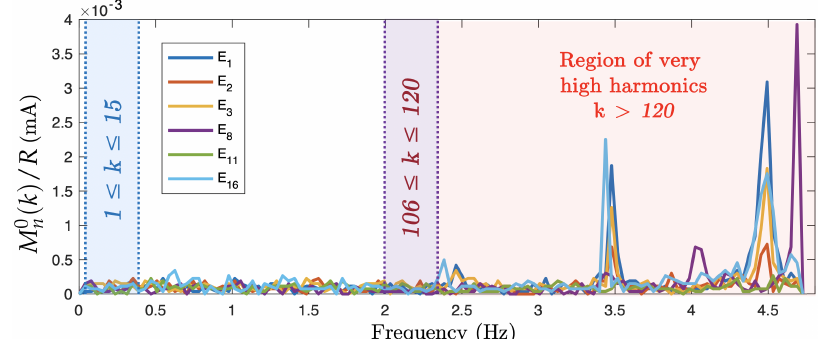
Figure 9. Noise measured over the full spectrum available for the sampling rate of 1 MS/s. The results show five of the 16 electrode channels. The low, high, and very high harmonic ranges are also